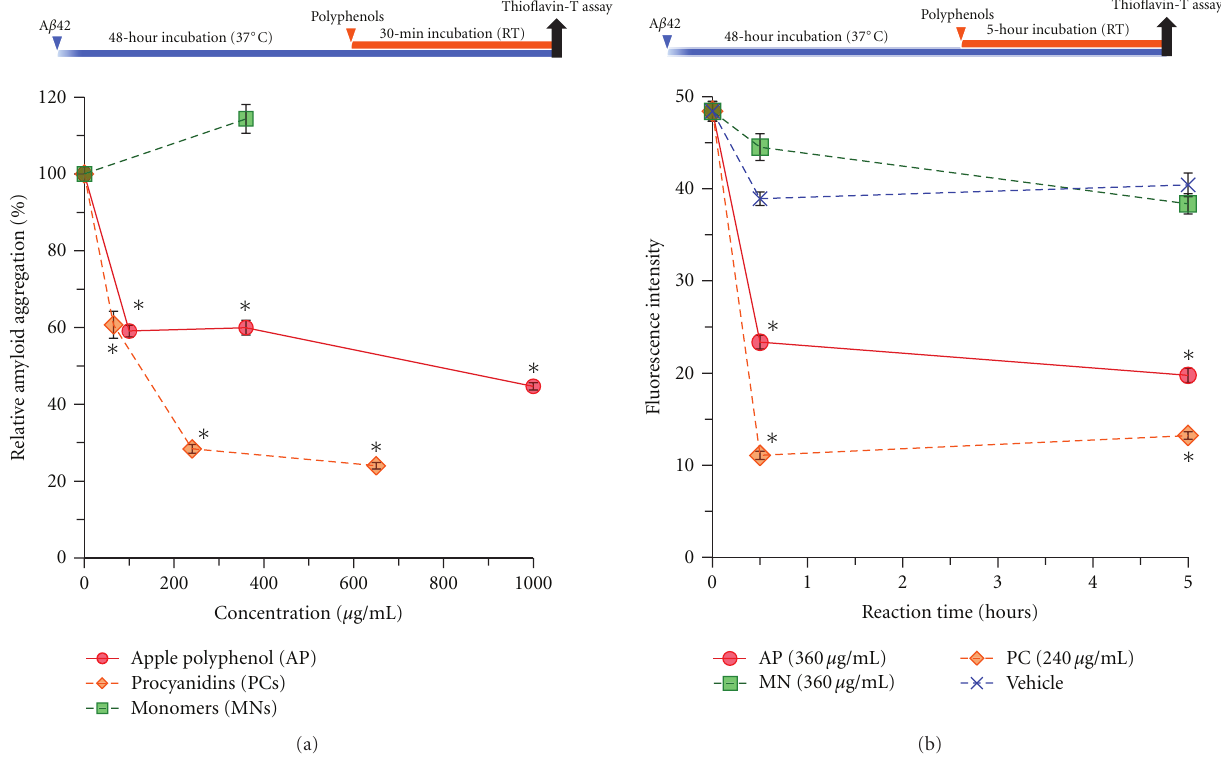
Figure 3: Procyanidins dissolve A β aggregates in vitro. (a) Dose-dependent dissociation of A β 42 aggregates by polyphenols determined using Th-T analysis. Samples were preincubated with A β 42 for 48 hours (final concentration 20 μ M) and then incubated with various concentrations of AP, PC, or MN for an additional 30 minutes. (b) Time-dependent A β 42 disaggregation in the presence of polyphenols determined by the Th-T assay. Samples were preincubated with A β 42 (20 μ M) for 48 hours and then incubated with AP (360 μ g/mL), PC (240 μ g/mL), or MN (360 μ g/mL). (Compared to vehicle groups, ∗ P < 0 . 001 (Dunnett’s test)). Values are the means ± s.e.m., n =